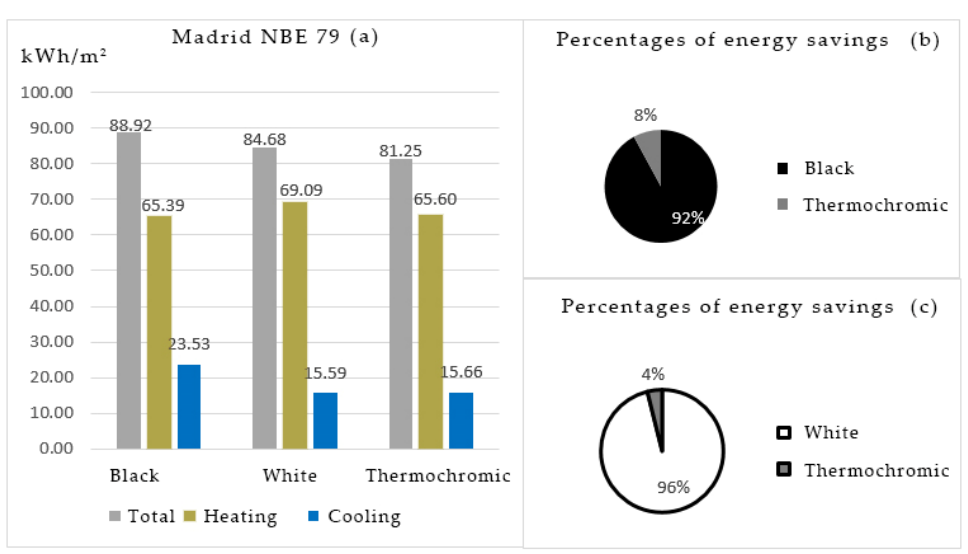
Figure 15. ( a ) Energy demand for heating and cooling in the case of Madrid NBE-79. ( b ) Thermochromic vs. black surface finish energy savings ( c ) Thermochromic vs. white surface finish energy savings.